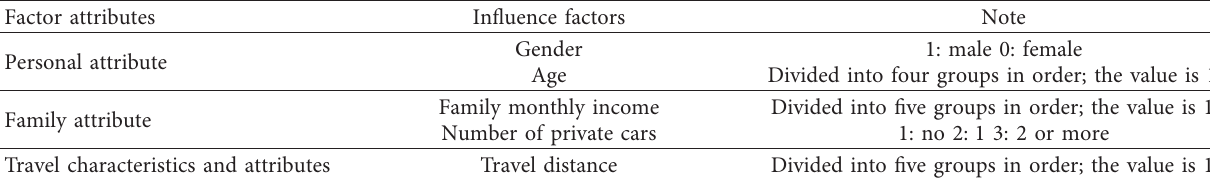
Table 2: Analysis of influencing factors of residents’ choice of travel